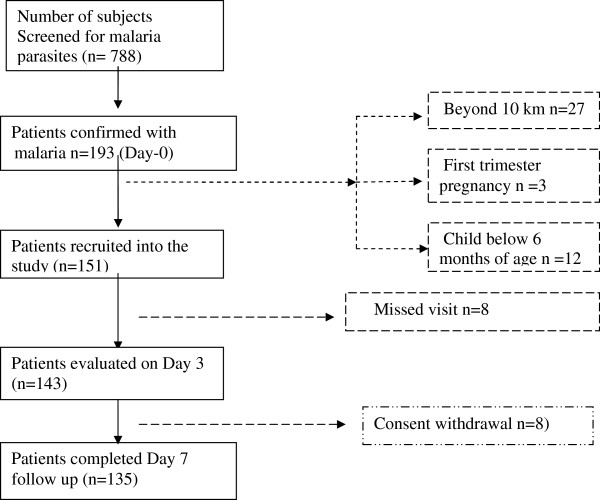
Number of patients traced and interviewed and those not traced.